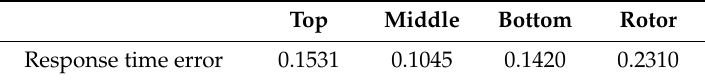
Table 2. Response time measurement